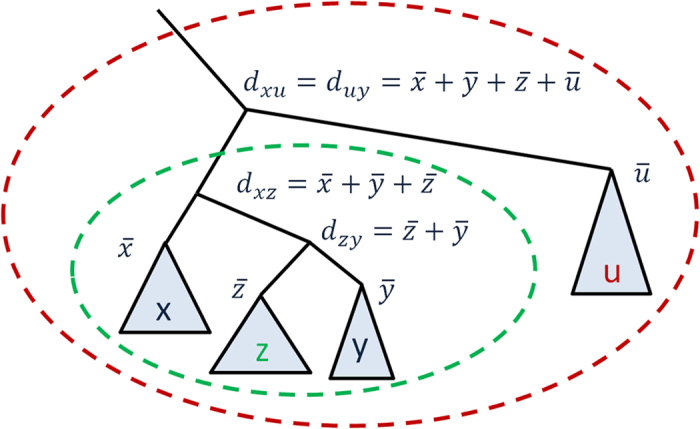
Tree-guided selective consistency of Sxy posterior matrix with threshold T.Triangles represent subtrees with sequences x, y, z, and u. At each node, a size of a subtree is given. In the example, selectivity procedure accepts relaxation of Sxy through z as α(dxz, dzy) ≤ T (green oval). At the same time it excludes sequence u from the consistency due to α(dxu, duy) > T (red oval).